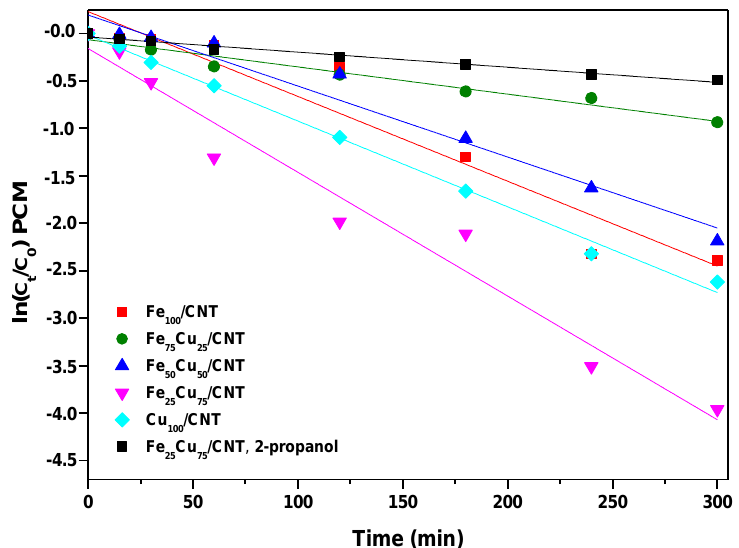
Figure 5. Decomposition kinetics of paracetamol (PCM; C 0 = 50 mg/L) at 25 °C on Fe 100−x Cu x /CNT samples. C 0 of H 2 O 2 : 13.8 × 10 −3 mol/L. Initial pH: 6.3‒6.6. Inset: Decomposition kinetics of PCM for Fe 25 Cu 75 /CNT catalyst in the presence and absence of 2-propanol.